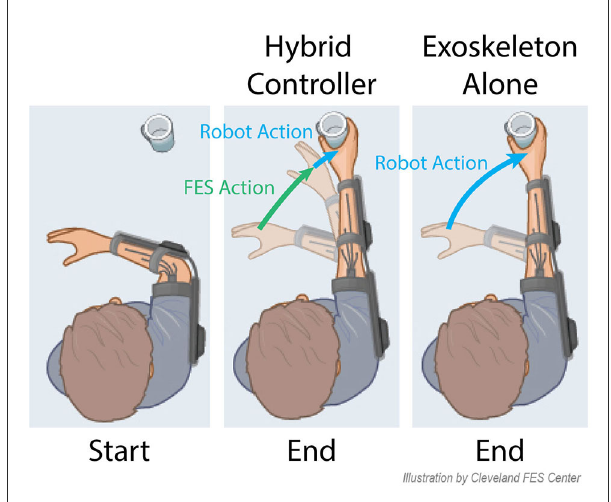
FIGURE1 An example future application of hybrid systems is shown for a reach and grasp task. The incorporation of both FES and a robot allows for a large portion of the movement to be provided by FES, and the robot can provide small amounts of power to provide minimal movement corrections. With the robot alone, all power for the movement must be provided by the robot.